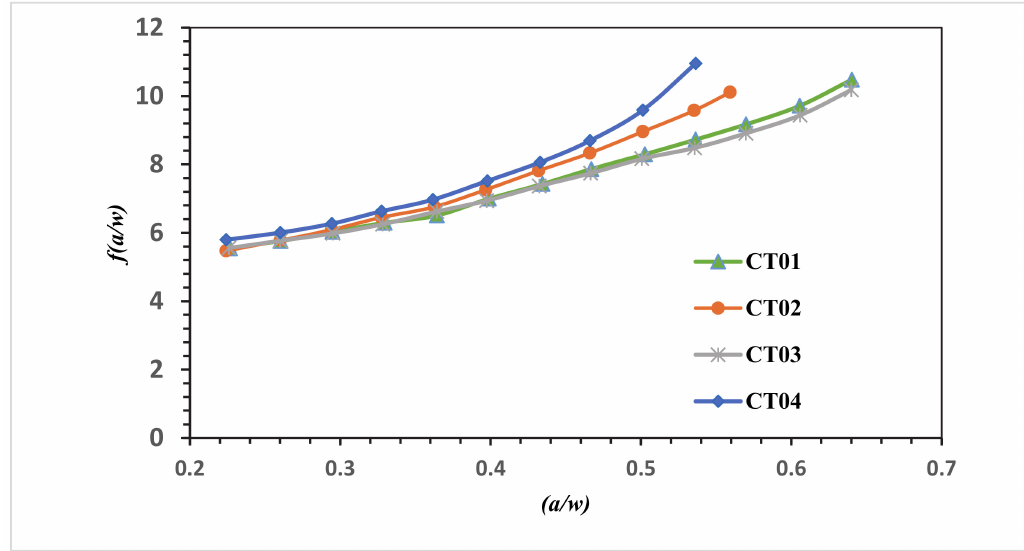
Figure 14. Dimensionless SIF of di ff erent configuration of